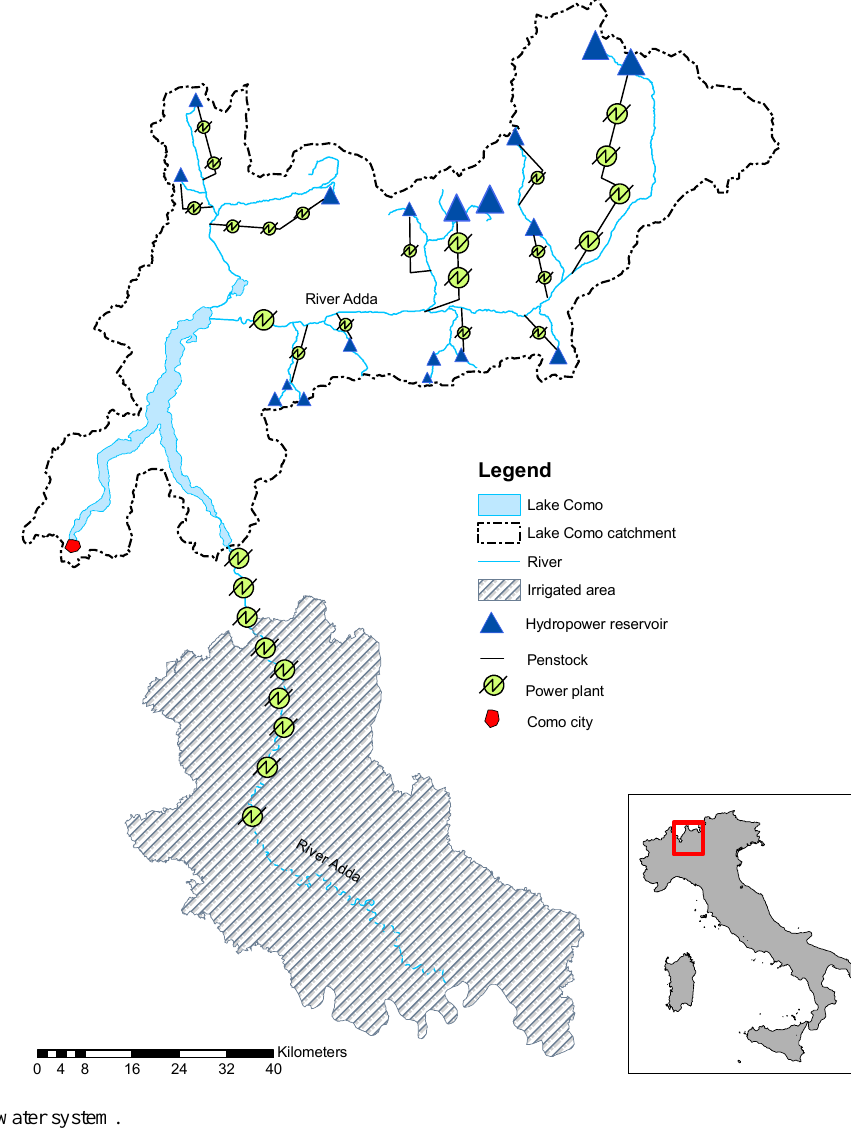
Fig. 1. Lake Como water